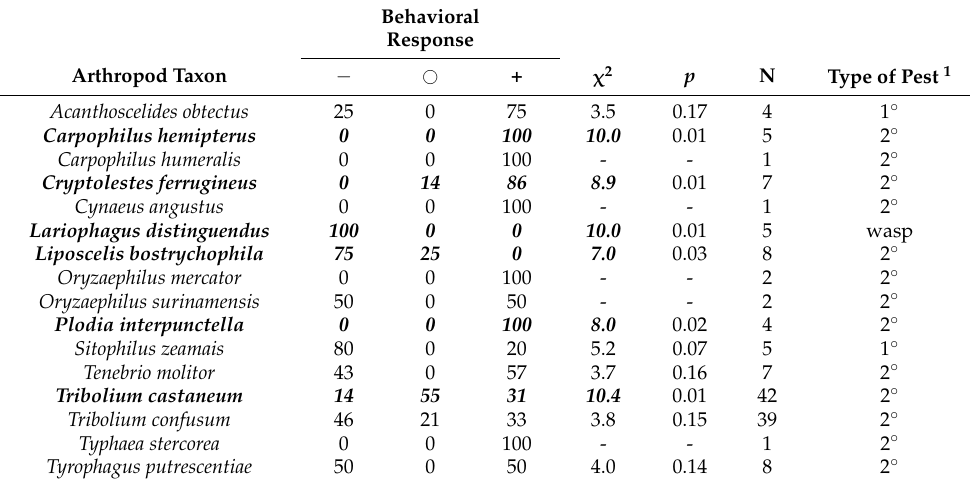
Table 1. Summary of the percent documented occurrences in the primary literature of attraction (+), repellency (−), or no statistical difference from included controls ( ○ ) by each of the following stored-product arthropod species among complex blends of microbial cues.